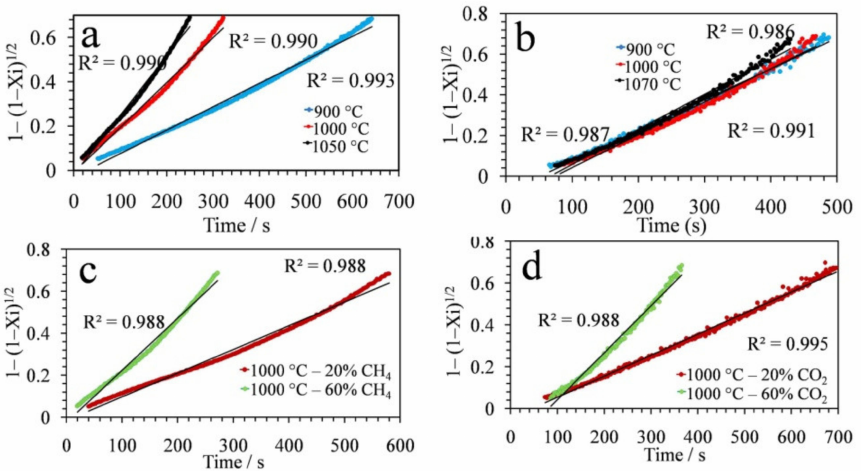
Figure 6. Comparison of experimental conversion data with 2D SCM (R2) predictions for CeO 2 during ( a ) CH 4 -induced reduction at selected temperatures, ( b ) CO 2 -induced re-oxidation at selected temperatures, ( c ) varying CH 4 partial pressure during reduction, and ( d ) varying CO 2 partial pressure during re-oxidation. The partial pressure of the reactant gases was kept at 40% in ( a , b ). Experiments with varying partial pressures in ( c , d ) were carried out at 1000 ◦